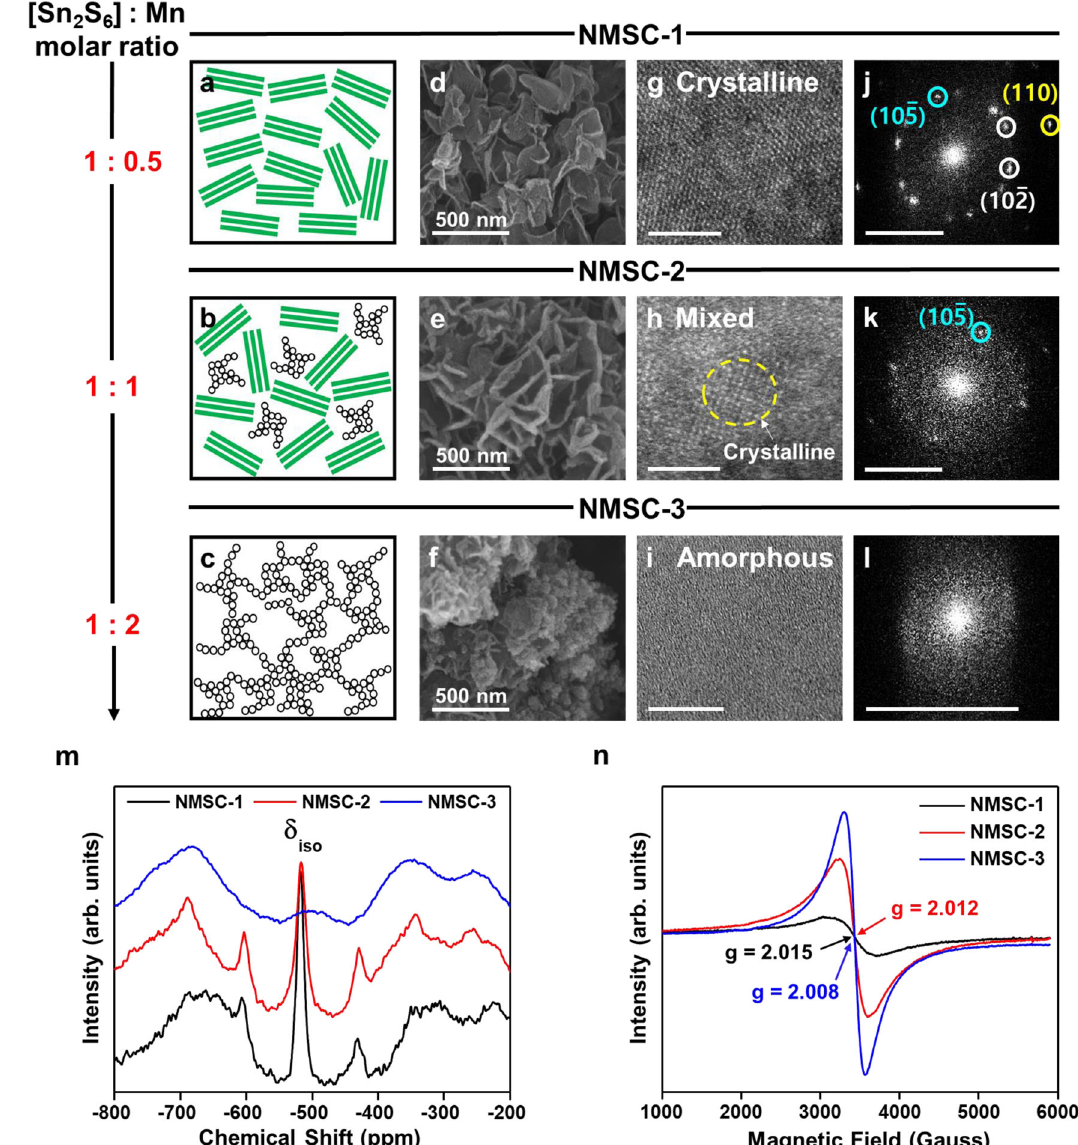
Fig. 3 | Morphological and structural transformation control (layer – amorphous) for various stoichiometric NMSC ratios. a – c Scheme